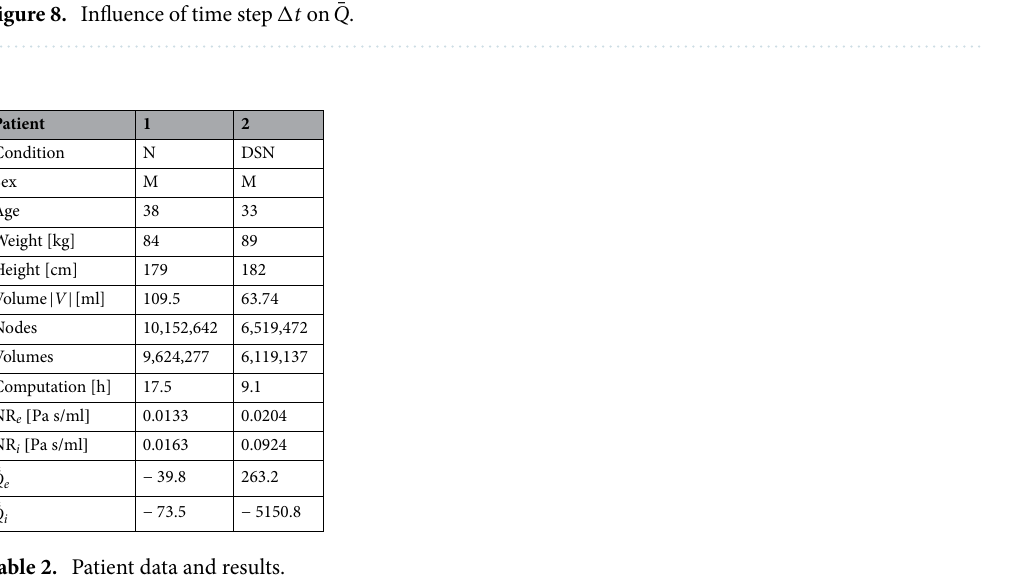
Figure 8. Influence of time step (cid:31) t on